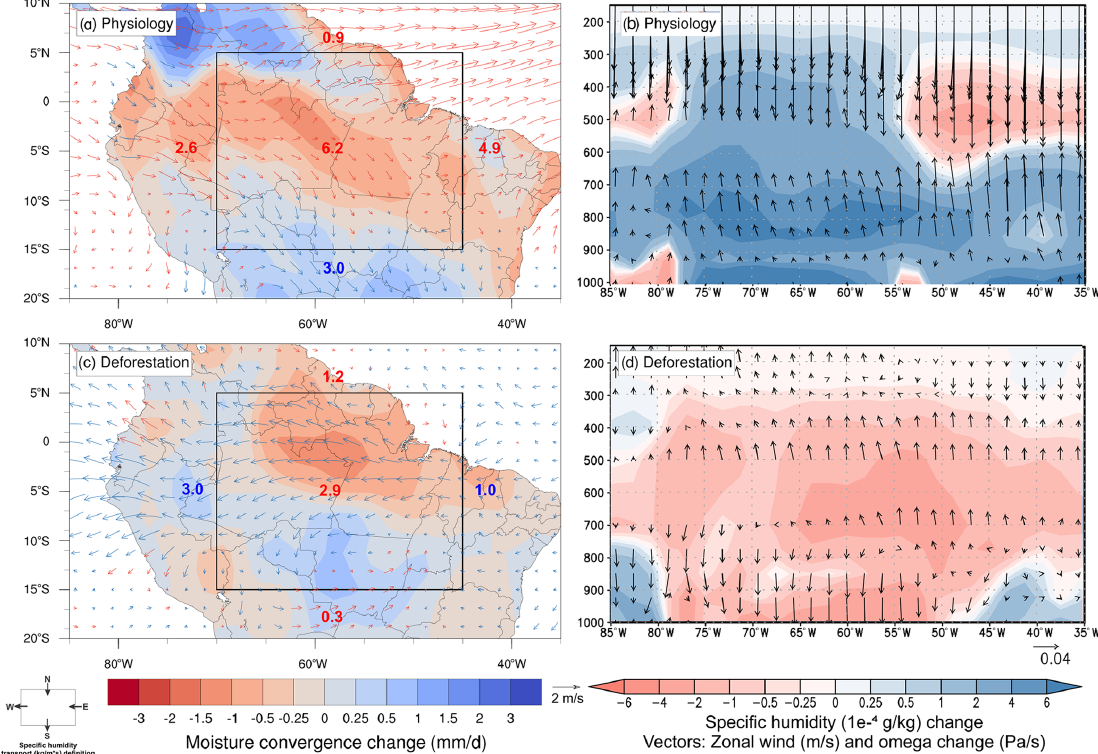
Figure 5. Annual mean changes in the 850hPa horizontal wind (a, c) and the vertical profile of zonal circulation over the Equator superposed on a meridional mean specific humidity vertical profile (with pressure in hPa as vertical coordinate) (b, d) in tropical South America under an atmospheric concentration of + 200ppmv (1.5 × CO 2 ) (a, b) affecting solely surface vegetation physiology and (c, d) with the complete substitution of the Amazon forest by pasture grasslands. The black square depicts the region over the Amazon for which changes in the spe- cific humidity flux balance (kgm − 1 s − 1 , integrated up to 500hPa) are calculated. The red and blue arrows and numbers represent decreases and increases, respectively, of the given